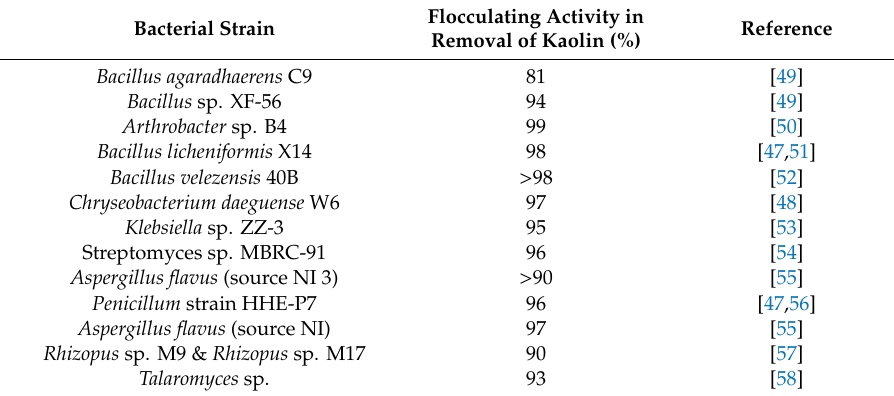
Table 1. Microbial strains and their respective flocculating